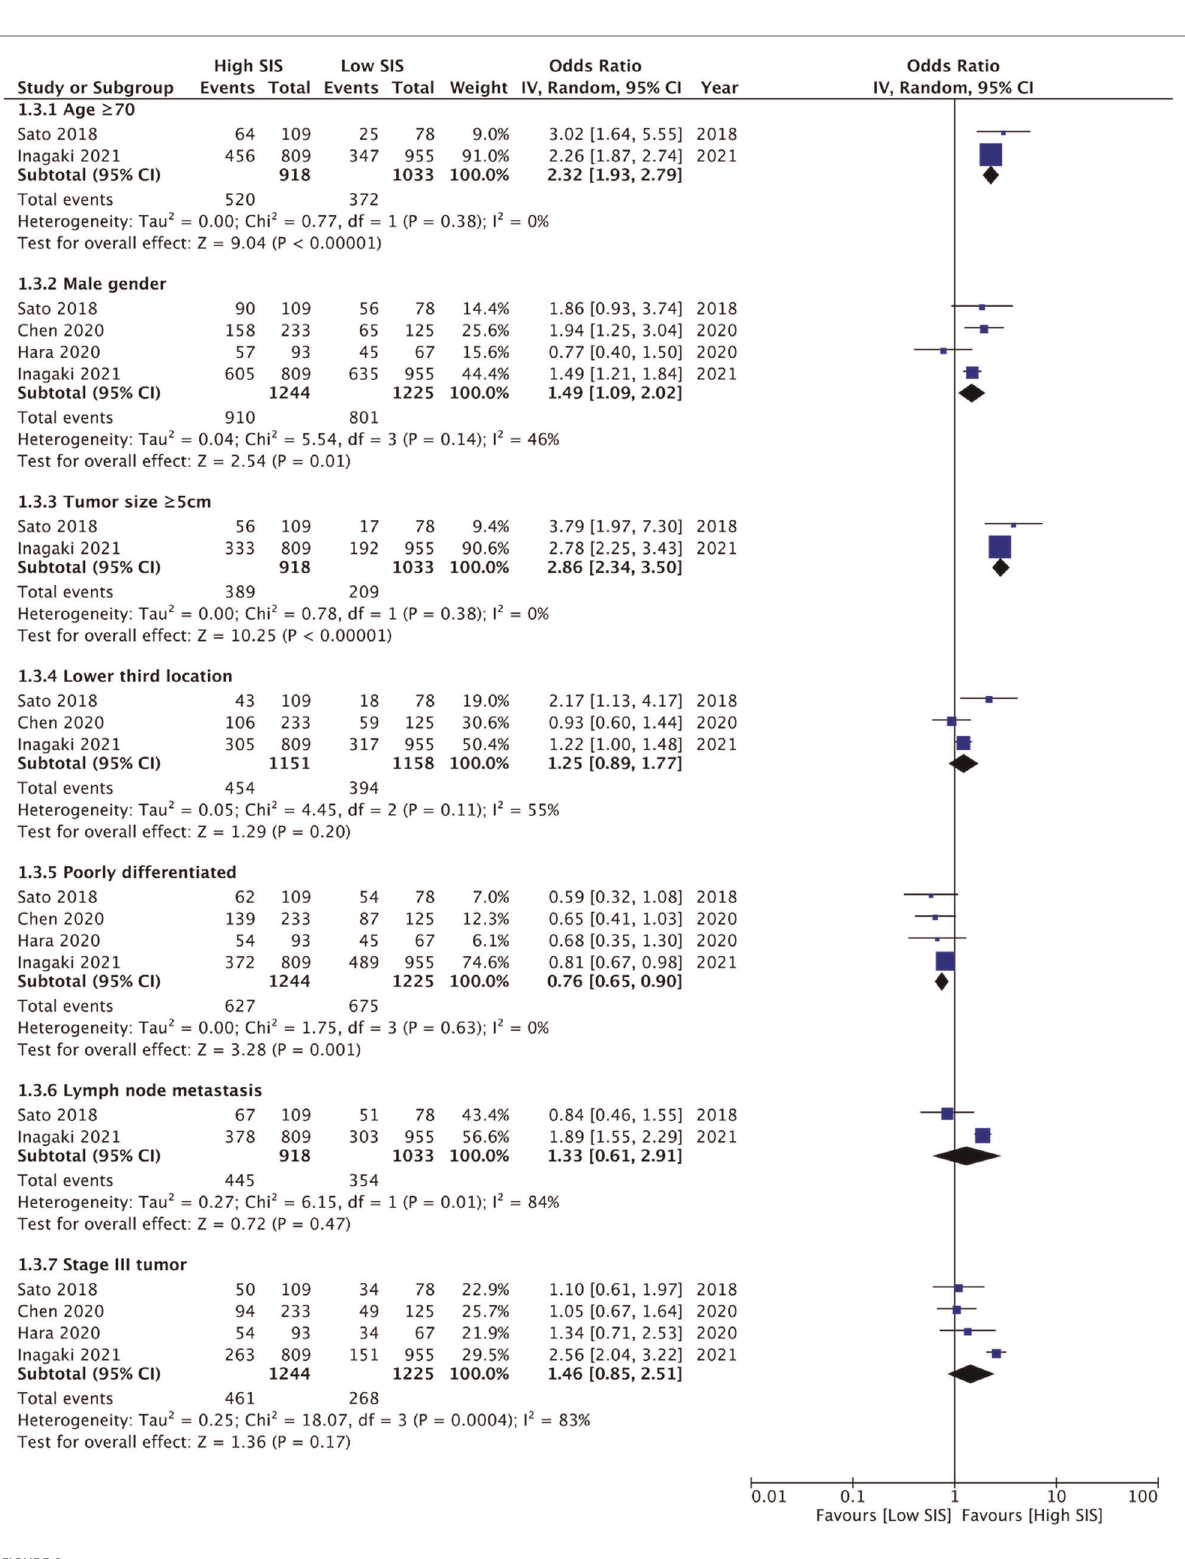
FIGURE 2 Meta-analysis assessing the relationship between high SIS and clinicopathological features of gastric cancer namely, age ( ≥ 70 years vs. <70 years), gender (male vs. female), tumor size ( ≥ 5 cm vs. <5 cm), location (lower third vs. other sites), differentiation (poorly differentiated vs. well differentiated), lymph node metastasis (present vs. absent), and tumor stage (stage III vs. stage I – II). Blue boxes indicate the point estimates of individual studies and horizontal lines denote the con fi dence intervals. Black diamond indicates the total effect